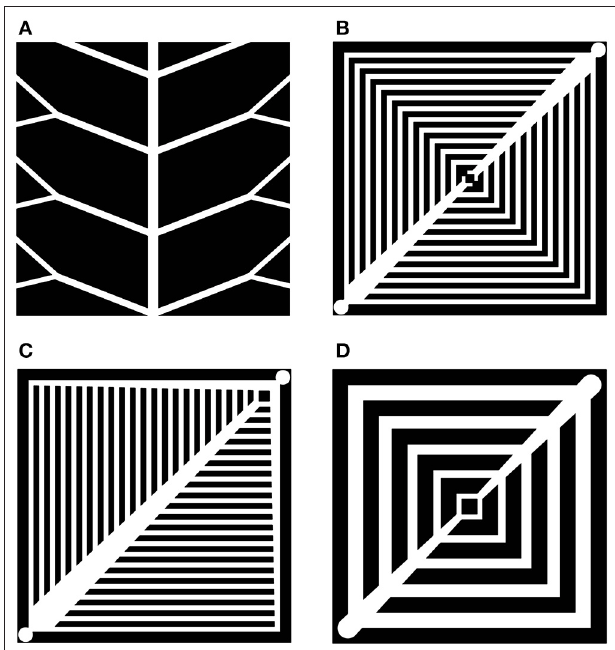
FIGURE 9 | Sketches of leaf-inspired FFP designs: pinnate venation with two branching angles (A) (from Damian-Ascencio et al., 2007), parallel with two (B) and three (C) tapered channels, and with gradually decreased widths of the side branching channels (D) (from Ozden et al., 2017).